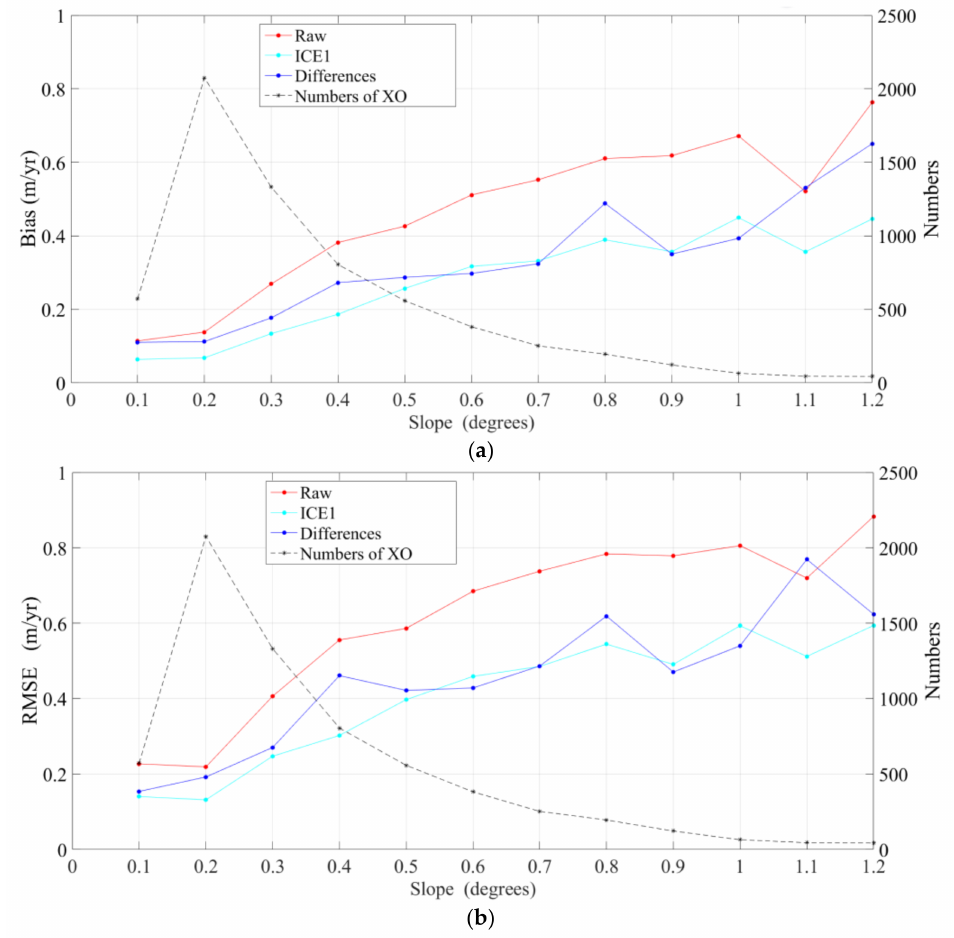
Figure 4. Statistics of the comparison in the crossovers as a function of surface slope marked in red for SARAL data with the ICE1 retracker and in cyan for SARAL data without waveform retracking. Statistics of the differences between SARAL and ICEBridge data as a function of surface slope marked in blue. Bias ( a ) and RMSE ( b ) in the slope interval of 0.1 ◦ . The black asterisks show the number of crossover points of SARAL data with the ICE1